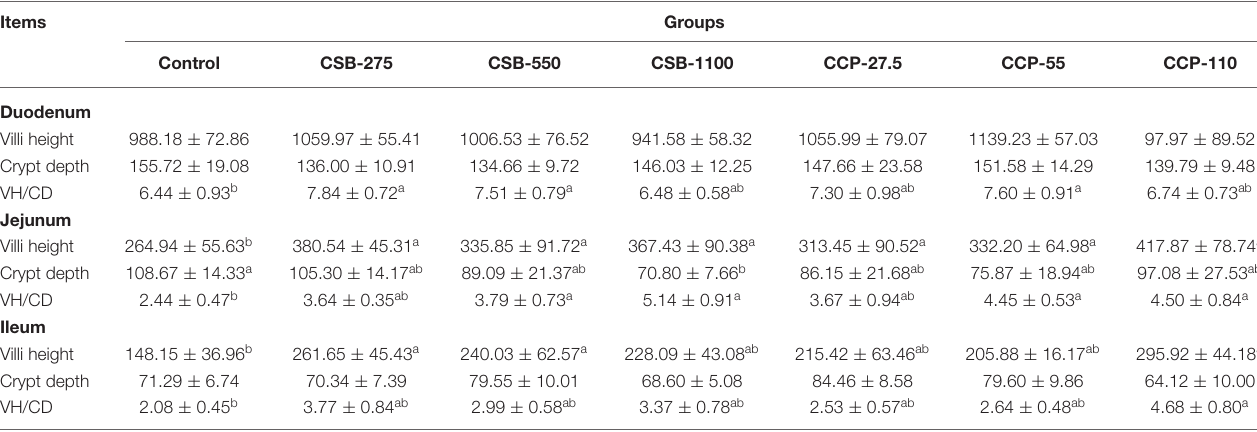
TABLE 3 | Effects of coated sodium butyrate (CSB) and polysaccharides from Cordyceps cicadae (CCP) on the villi height ( µ m), Crypt depth ( µ m) and VH/CD of the duodenum, jejunum, and ileum of squabs. Items